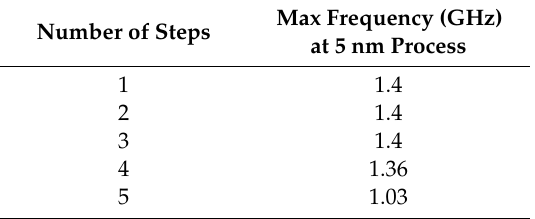
Table 4. Synthesis result of MED implementations to check achievable